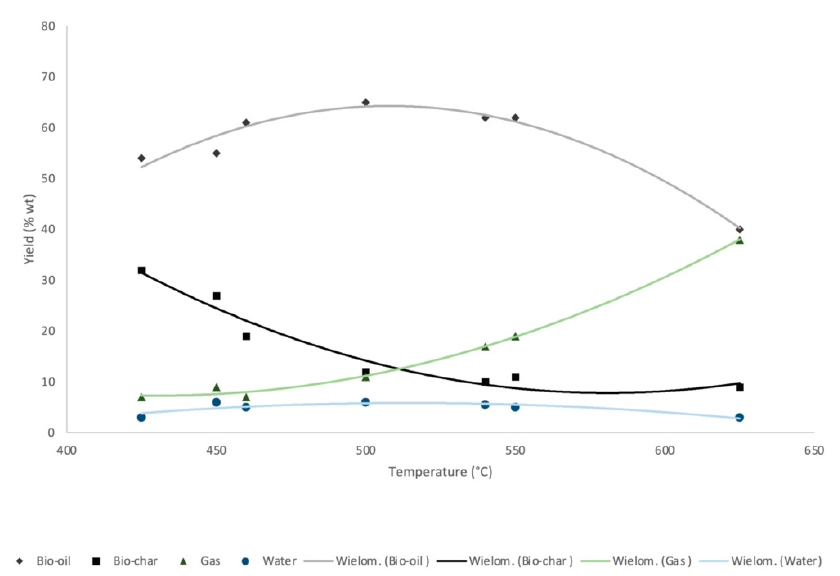
Figure 3. Variable product yield from fast pyrolysis at different temperatures; adapted from the International Energy Agency [ 29].